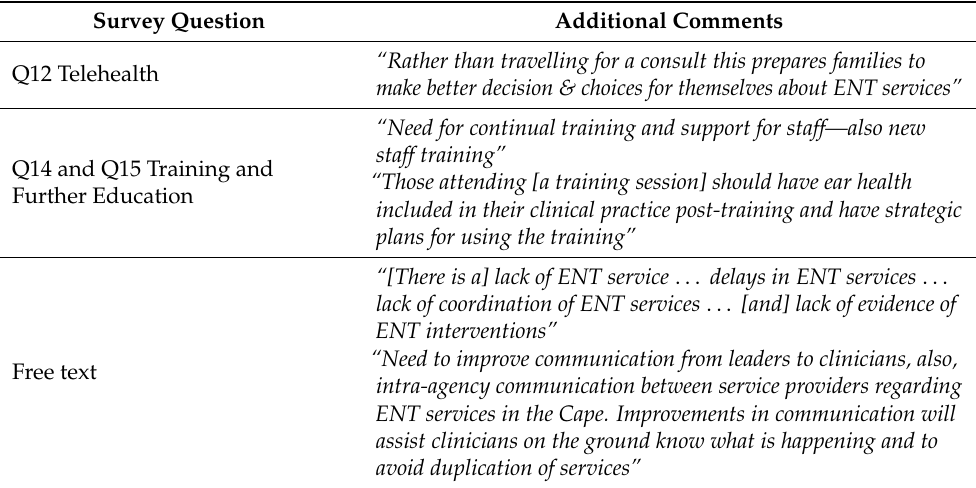
Table 1. Unprompted, additional comments made in the primary health care (PHC) clinician survey.